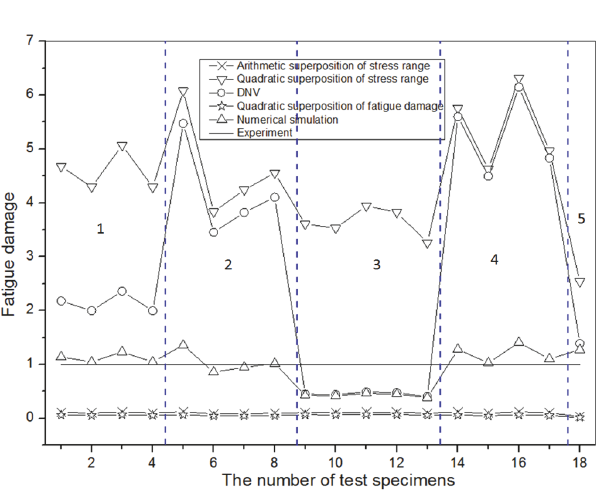
Figure 13: Fatigue damage result for different approaches.